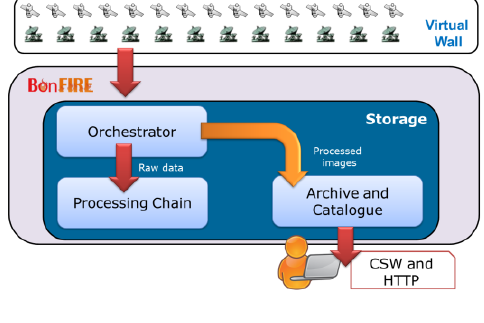
Figure 1. Cloud Architecture in BonFIRE